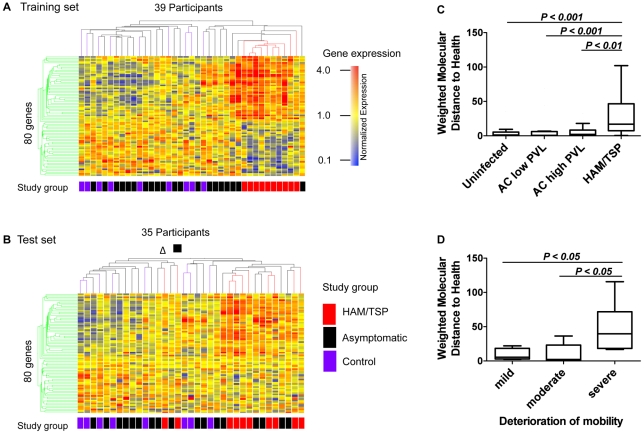
Presence of an 80-gene blood transcriptional signature in HAM/TSP.The blood expression levels of 80 genes differed between patients with HAM/TSP and clinically asymptomatic HTLV-1 carriers and uninfected individuals. (A) Microarray training and (B) test set gene expression profiles. Participants were clustered in hierarchical condition trees (Spearman correlation with average linkage) with each row representing a single gene and each column an individual subject. Color scale indicates normalized expression values and colored boxes below the trees indicate the individual's clinical classification (study group). ACs with high or low HTLV-1 proviral load were not distinguished by color because their results did not differ significantly either in hierarchical clustering or WMDH analysis. (C) Quantification of transcriptional changes in the 80 genes. The ‘weighted molecular distance to health’ metric [12] was calculated for each patient and the median compared between study groups (Mann-Whitney test). (D) Correlation between the transcriptional signature and the clinical severity of HAM/TSP. Extent of impaired mobility was assessed by patients' performance in the 10-meter walk test (see methods). Graphs (C) and (D) comprise data of the training and test set. PVL = HTLV-1 proviral load. Box plot represent median ± 1.5 IQR. The P-values were calculated using a two-tailed Mann-Whitney test.